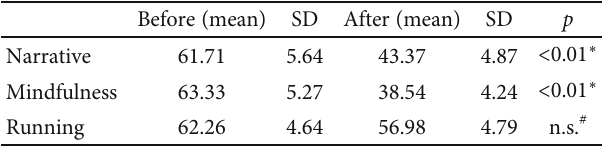
Table 4: E ff ects of mindfulness training on depression. Table 5: E ff ects of mindfulness training on blood cortisol